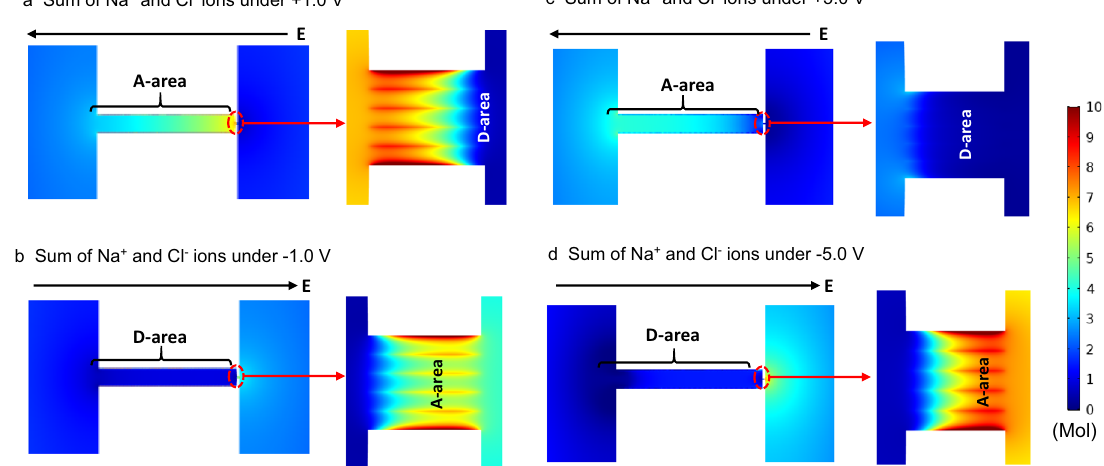
Fig. 3 Numerical simulation of the highly recti fi ed CMHPA. a Ion accumulation area (A-area) and depletion area (D-area) under a + 1.0 V bias. b Ion accumulation area and depletion area under a − 1.0 V bias. c Ion accumulation area and depletion area under a + 5.0 V bias. Under this condition, the voltage is large enough to overcome the energy barrier and pulls all ions out of the membrane segment. d Ion accumulation area and depletion area under a − 5.0 V